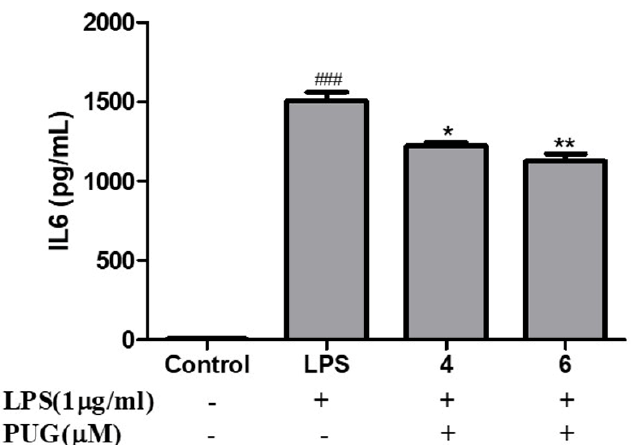
Figure 4. Effect of PUG on the pro-inflammatory cytokine interleukin-6 (IL-6) on activated RAW264.7 macrophage cells. RAW264.7 cells were pretreated without or with LPS (1 µ g/mL) for 1 h at 37 ◦ C. Then the cells were treated with PUG (4, and 6 µ M) for 24 h at 37 ◦ C. The treated cell culture media were collected and used for the IL-6 determination. The wells were read, and absorbance values were used for the graph plot. The standard deviation and error were calculated from the replicates of the samples and the Four Parameter Logistic curve (4PL) method was used to determine the IL-6 concentration. The statistical significance was ### p < 0.001 vs. untreated group; and * p < 0.05, ** p < 0.01 vs. LPS-alone treated group.